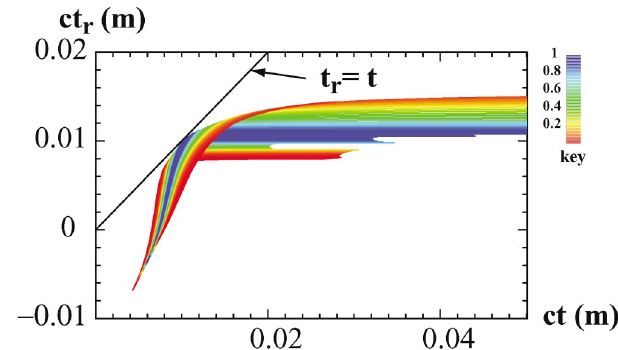
FIG. 11. (Color) Retarded time t example trajectories of Fig. 4(a). Color code indicates relative macroparticle